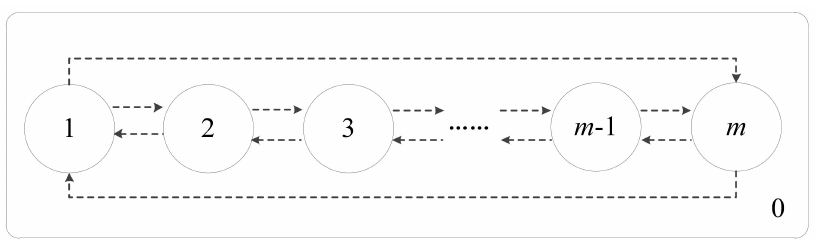
Figure 2. The membrane structure of